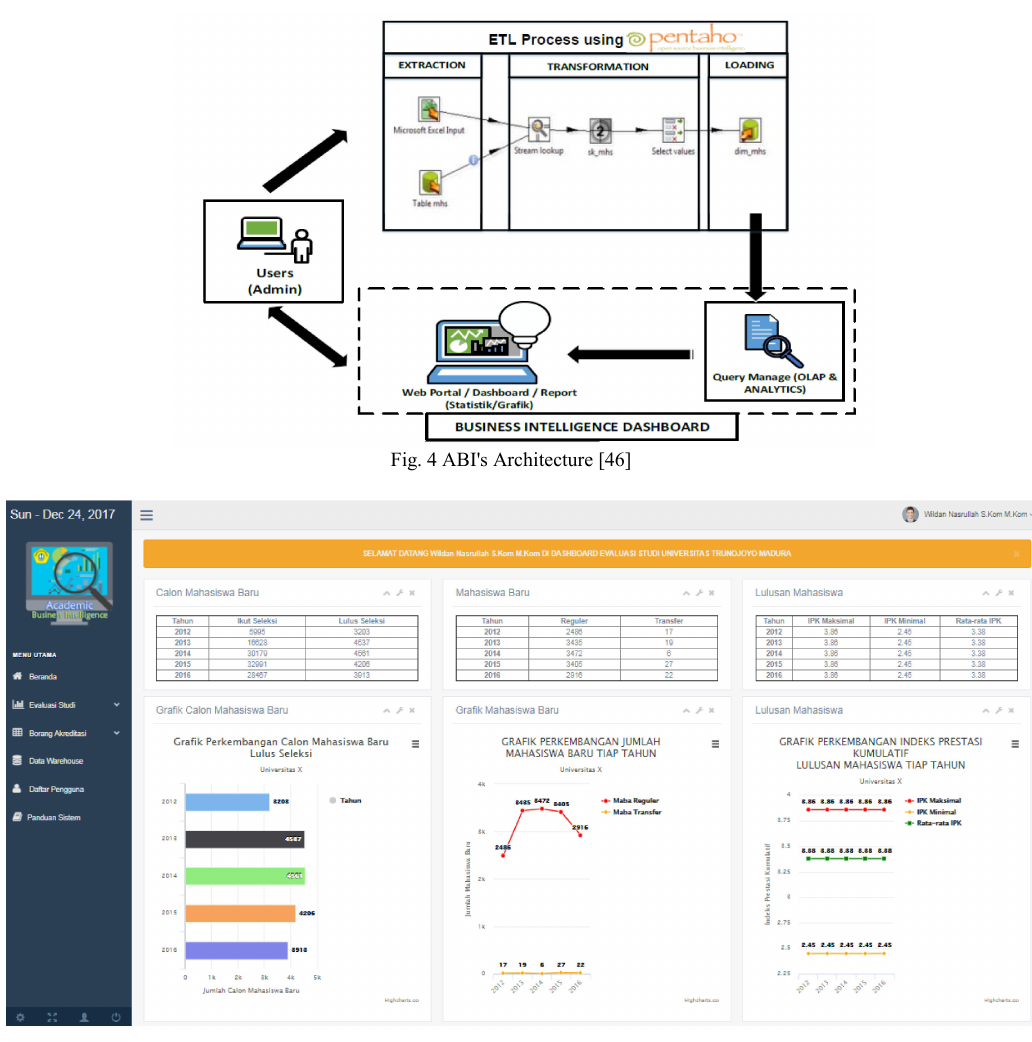
Fig. 5 Sample of ABI's feature for interactive students' performance